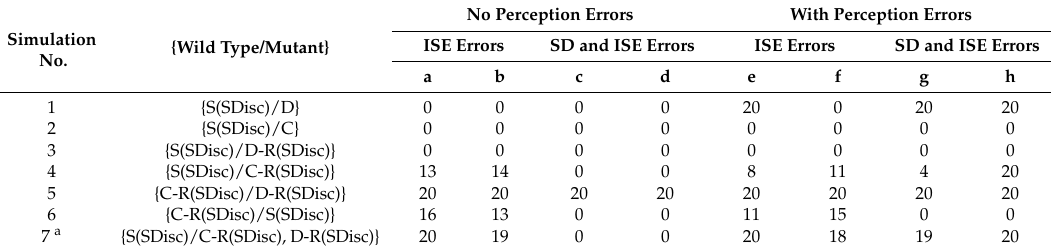
Table 8. Frequency of successful invasions under strict